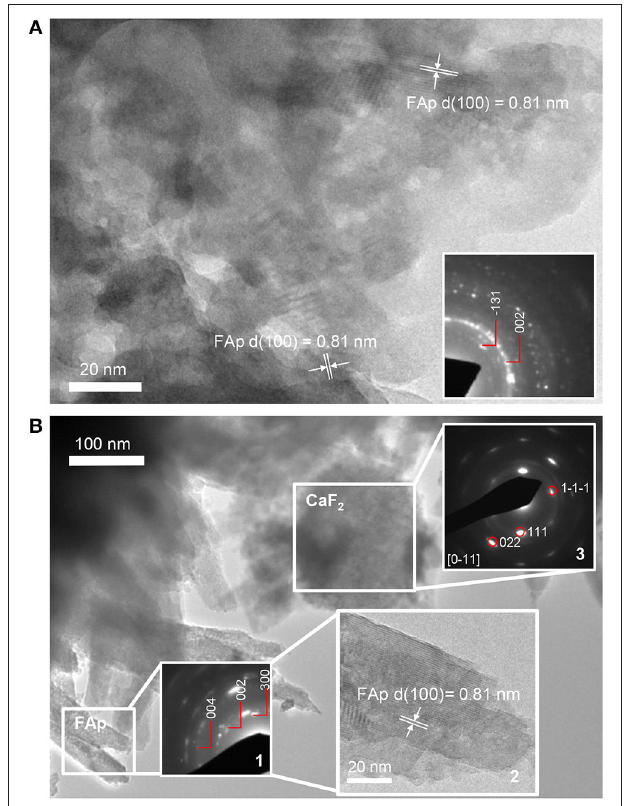
FIGURE 7 | TEM images of precipitate present in solution containing STNA15-ELP at (A) 3h and (B) 8 days of incubation (inset 2 showing the high resolution TEM image with FAp planes visible). The 3h precipitate is a nano-crystalline apatite. At 8 days the apatite has a needle-like form. The needles that were directly in contact had some co-alignment as seen in the SAED pattern (inset 1). The spherical particles, present at 8 days, were confirmed to be CaF 2 , from the SAED pattern (inset